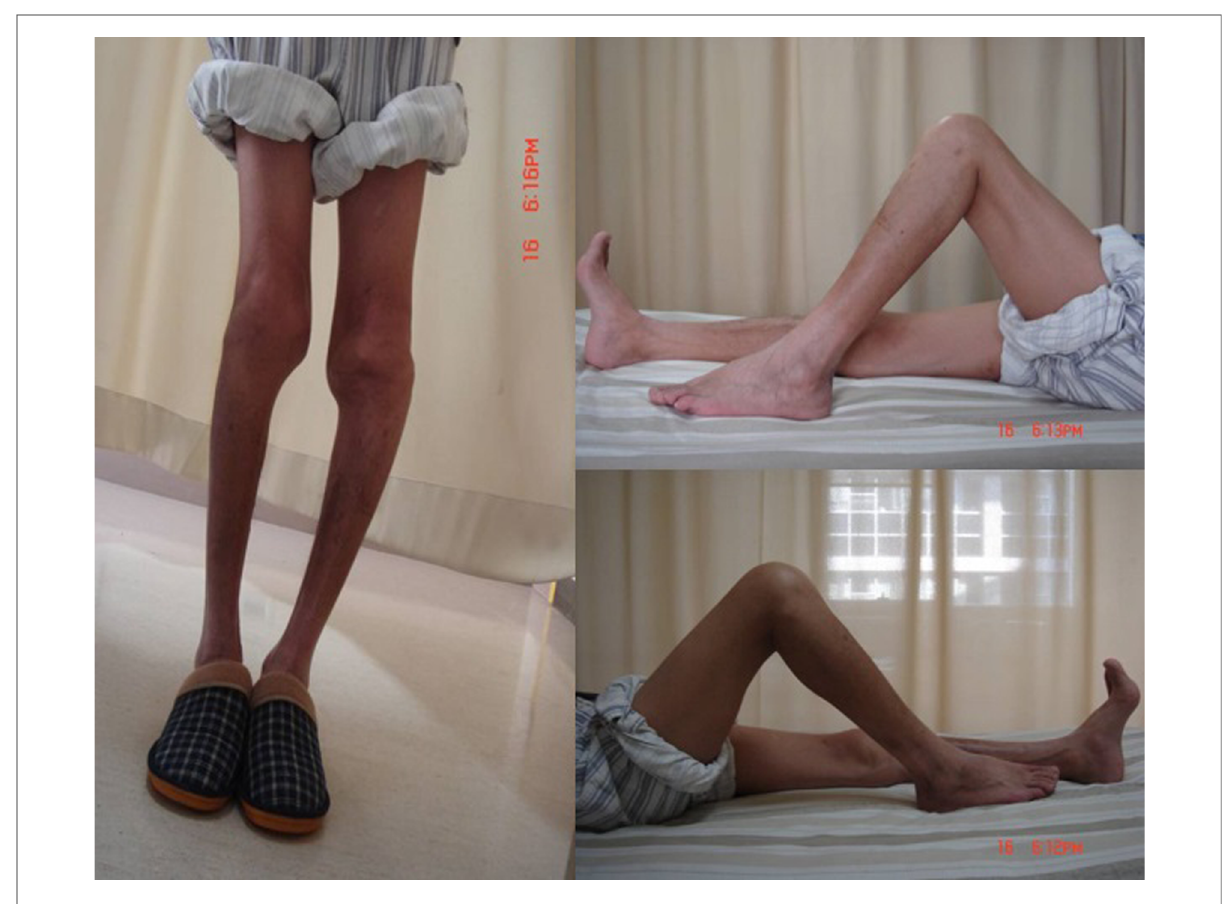
FIGURE 2 Clinical photograph showing preoperative deformity in patients with hemophilia.